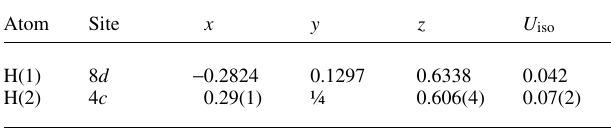
Table 2. Atomic coordinates and displacement parameters (in Å 2 ) .